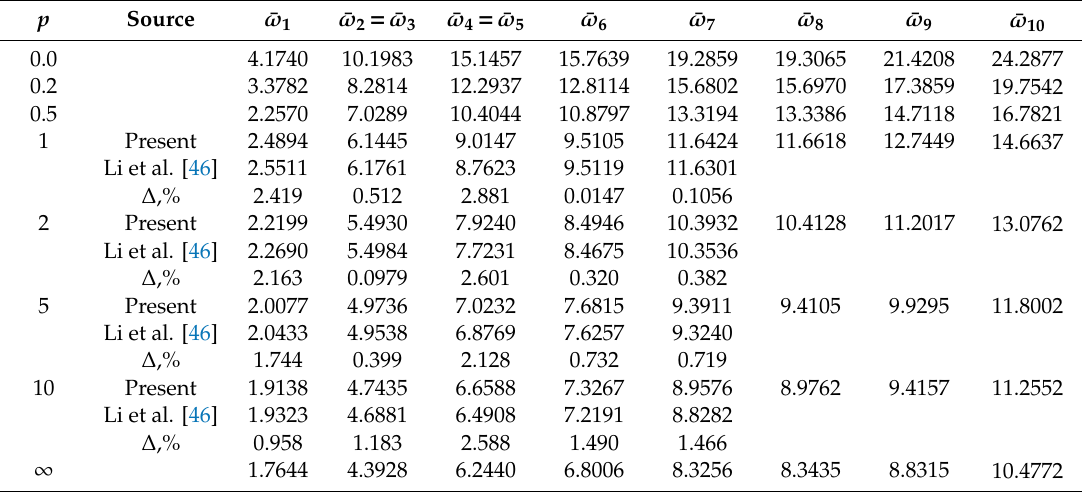
Table3. Thefirsttennondimensionalfrequenciesofsimplysupported(SSSS)SUS304 / Si 3 Ni 4 functionally graded square plates thermally loaded by the uniform temperature rise, T = 600 K.